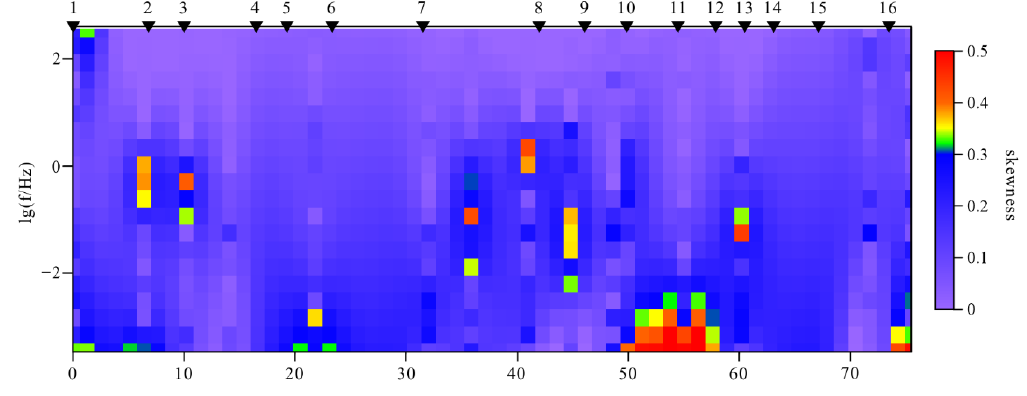
Figure 4. Two-dimensional deviation degree pseudo-section diagram (phase tensor decomposition).